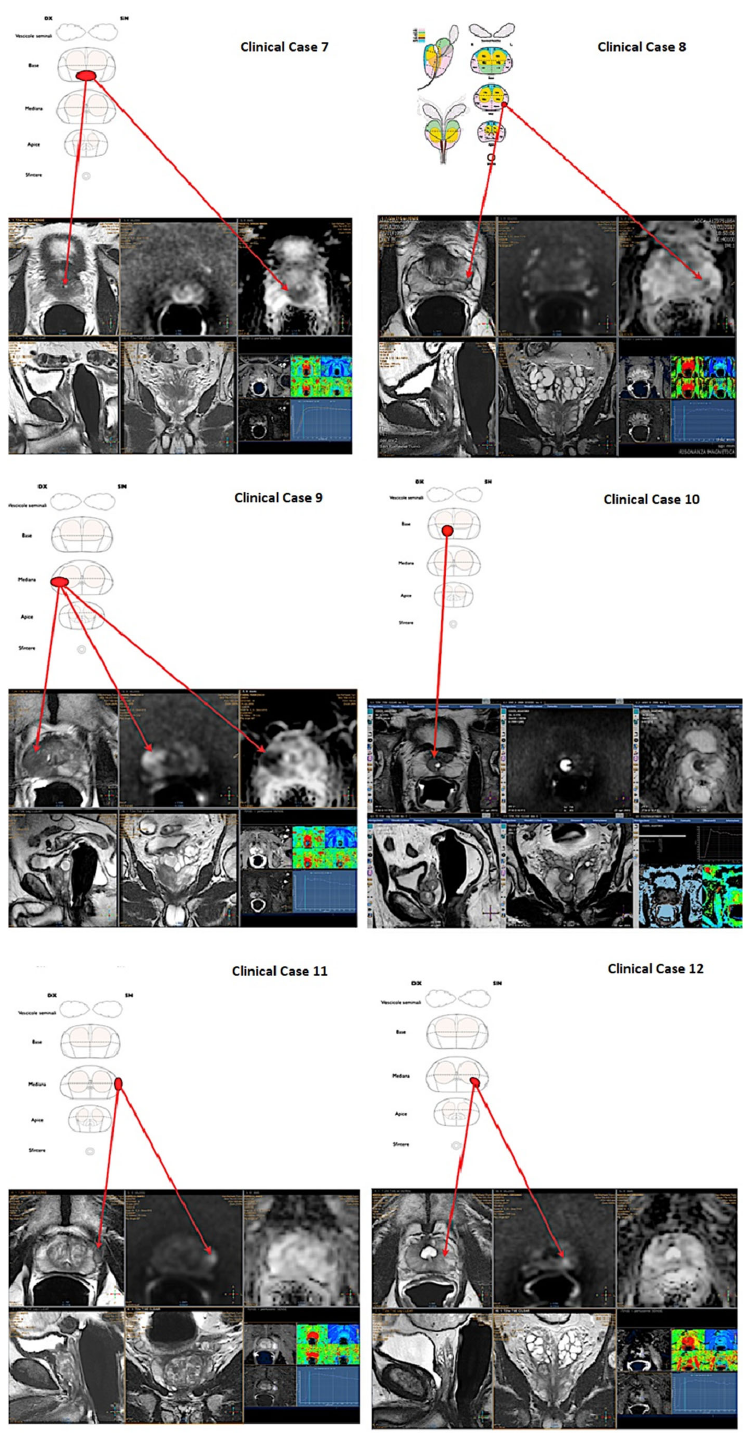
Figure 2. Second set of six mpMRI images used for urologists’ interpretation skills assessment .